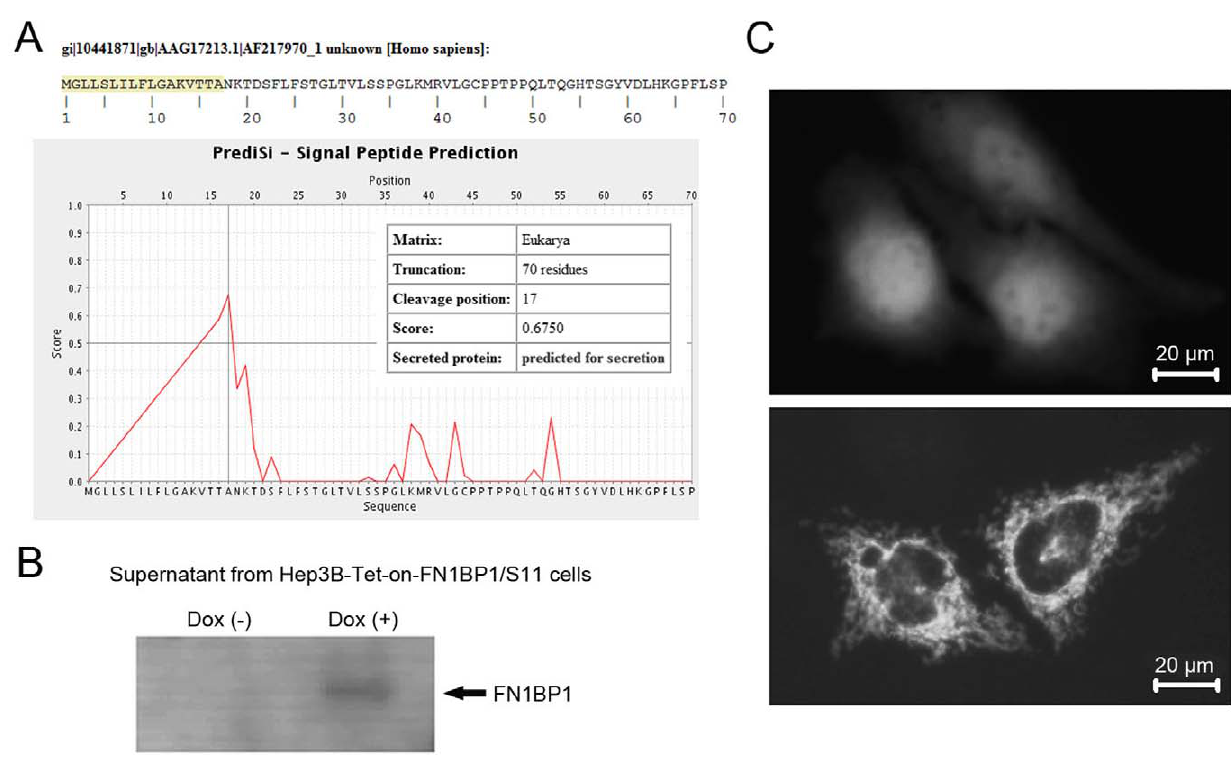
Figure 2. FN1BP1 is a secreted protein localized in the cytoplasm of Hep3B cells in vitro. (A) The FN1BP1 ORF was postulated to be a secreted protein with a signal peptide (SignalP software). To investigate whether the FN1BP1 gene is a secretory protein, we collected the supernatant of culture media from pcDNA3.1-FN1BP1 transfected cells to perform western blotting using anti-FN1BP1 antibody. (B) Compared with the supernatant of the media-cultured pcDNA3.1-transfected cells, FN1BP1 protein could be detected in the supernatant from the media of pcDNA3.1-FN1BP1-transfected cells by western blot analysis. To investigate the localization of FN1BP1 protein, the pEGFP-FN1BP1 recombinant plasmid was constructed and transfected into Hep3B cells. (C) After transfection for 48 h, the Hep3B cells were observed and the FN1BP1 protein- fused GFP accumulated in the cytoplasm. In the upper panel of Fig. 2C, control GFP is ubiquitously expressed in both nucleus and cytosol, while in the lower panel of Fig. 2C, GFP-FN1BP1 is expressed only in cytosol.